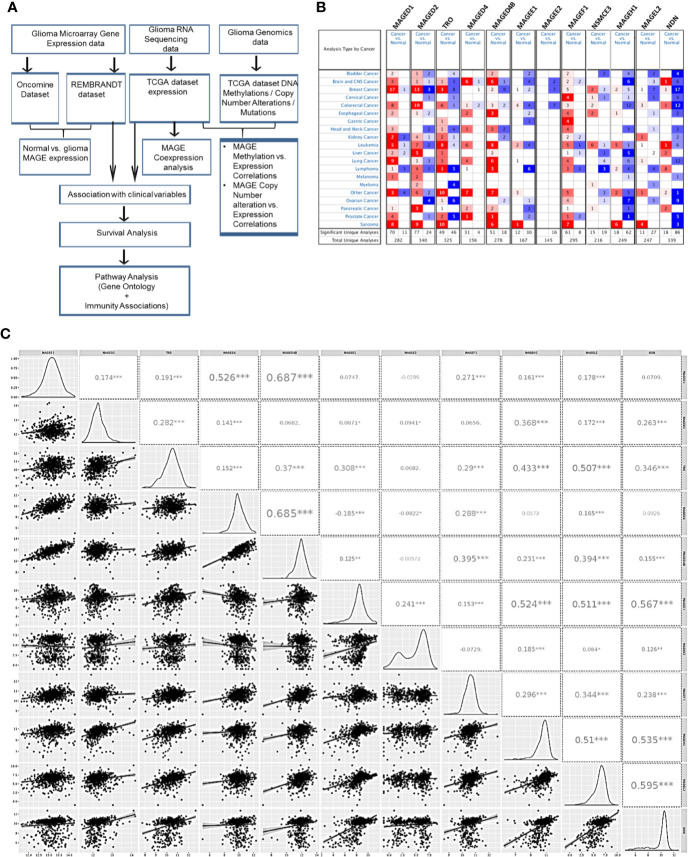
Type 2 MAGE expression in glioma. (A) Outline of the current study. (B) Oncomine analysis showing the general pattern of overexpression (red color)/downregulation (blue color) of T2Ms in cancer vs. normal tissues in different cancers. (C) Correlation matrix of T2Ms in a combined group of TCGA lower grade glioma and glioblastoma dataset. The distribution of variables is shown in left while Pearson correlation coefficients along with the level of significance have been shown on right. (***p<0.001; **p<0.01; *p<0.05).